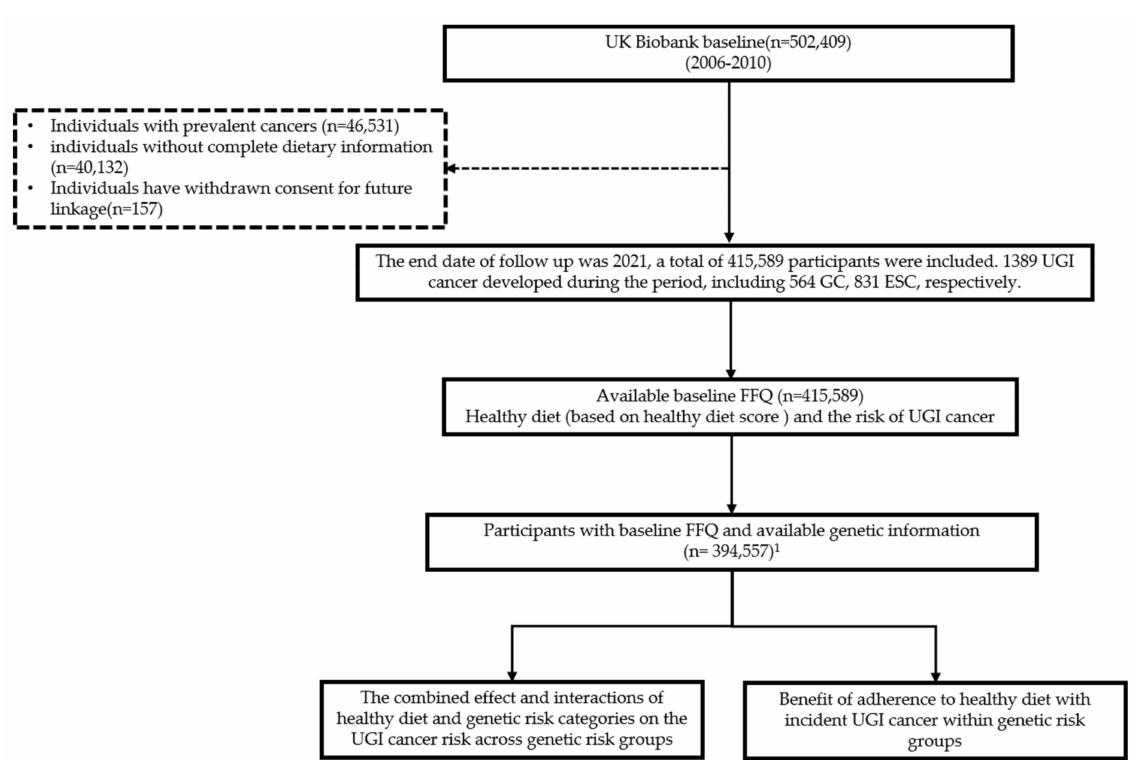
Figure 1. Study design and workflow. 1 For healthy diet and genetic risk on UGI cancer risk across and within genetic risk group analysis, participants without available genetic information were excluded ( n =